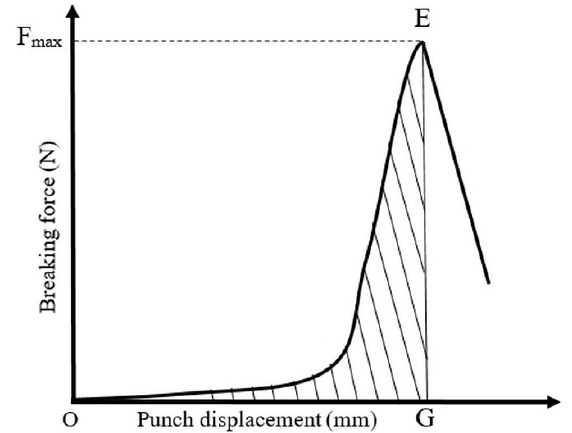
Figure 4. General diametral rupture curve of DiltTi compressed with 100 MPa. Table 2. Energetic parameters of titanate nanotubes (TNTs), active pharmaceutical ingredients (APIs) and TNT–API composite powders.